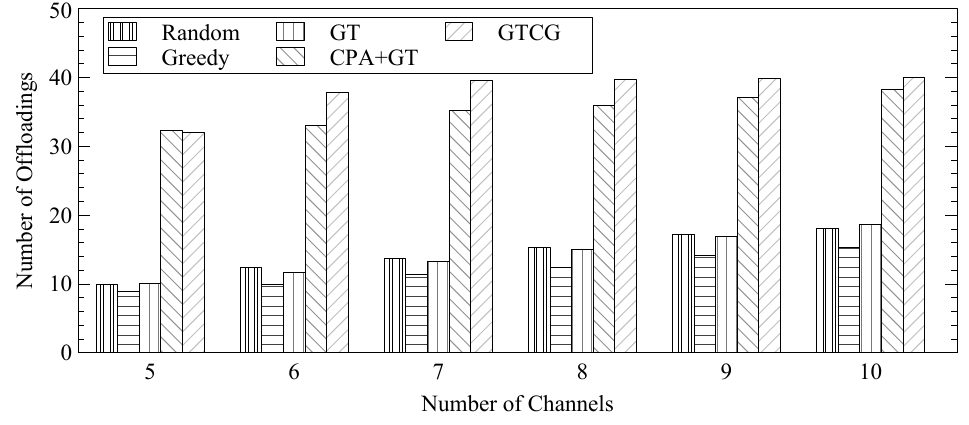
Figure 7. Average Number of Offloadings with Different Number of